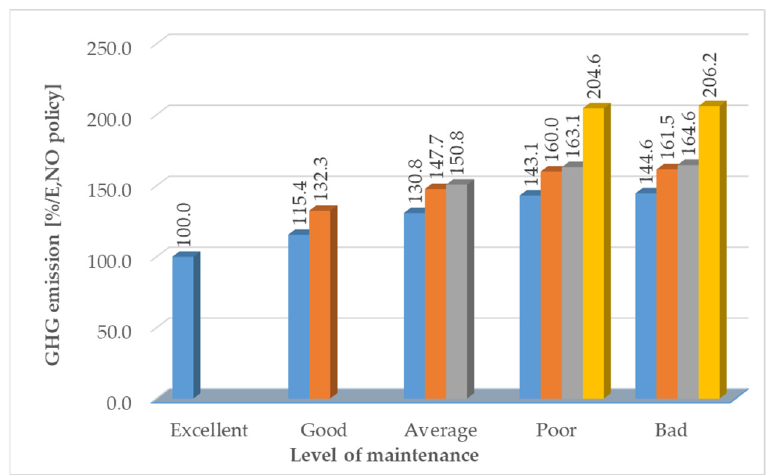
Figure A1. Proportion of GHG emission depending on the status and the performed maintenance operation.